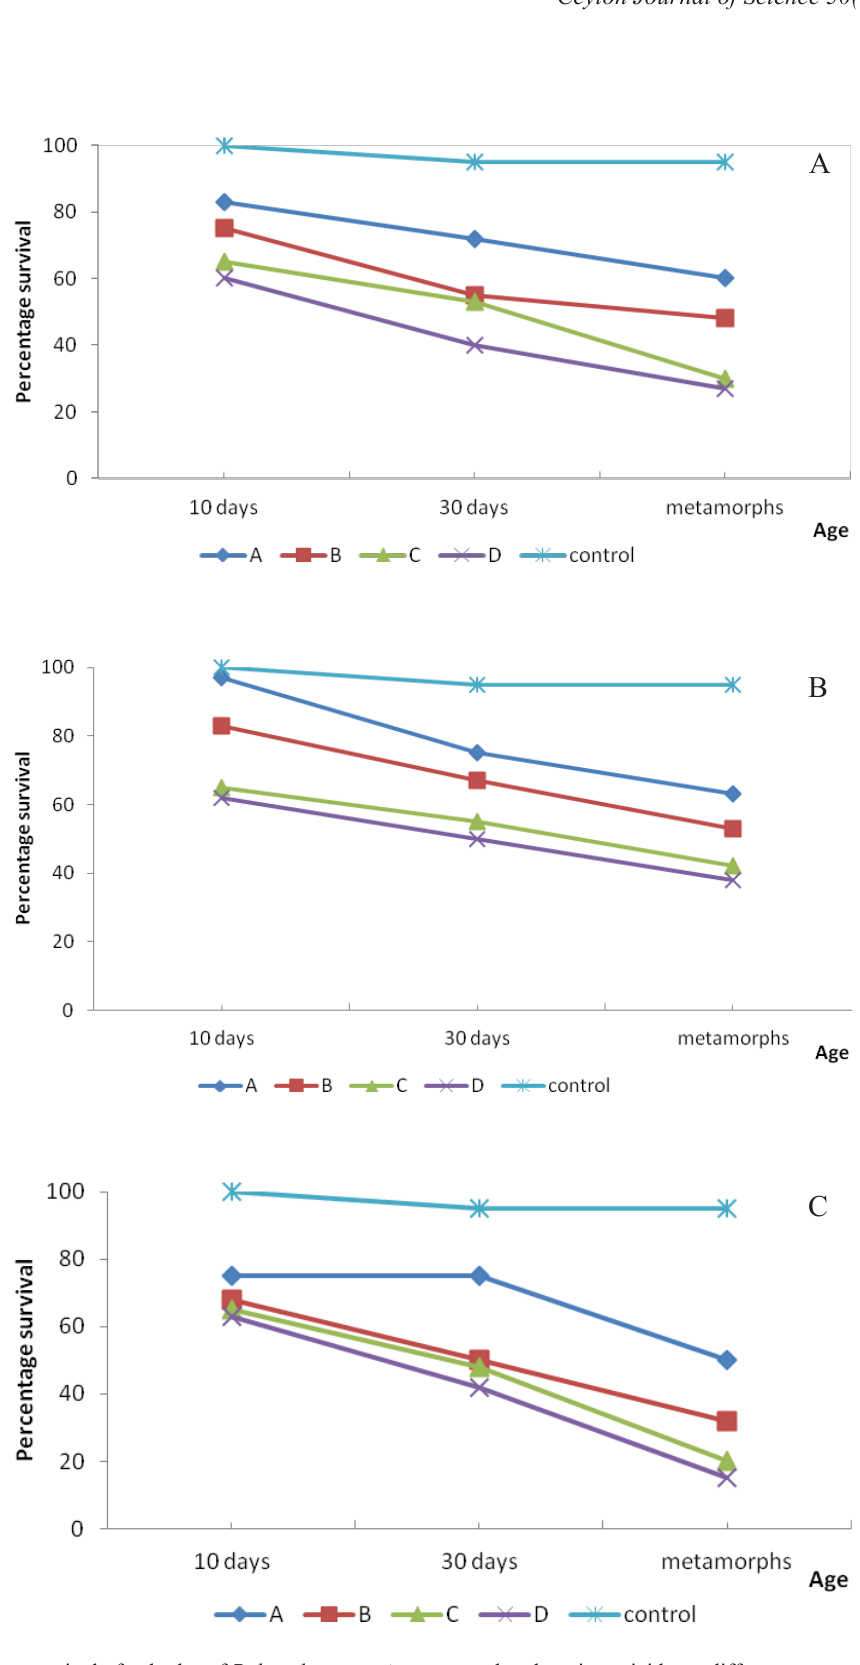
Figure 1: Percentage survival of tadpoles of Polypedates cruciger exposed to three insecticides at different concentrations and control. (1) Profenosfos A = 0.125, B = 0.250, C = 0.500, D = 1.000, (2) Diazinon; A = 0.375, B = 0.750, C = 1.5, D = 3 .0, (3) Carbosulfan; A = 1.5, B = 2.0, C = 2.5, D = 3.0.